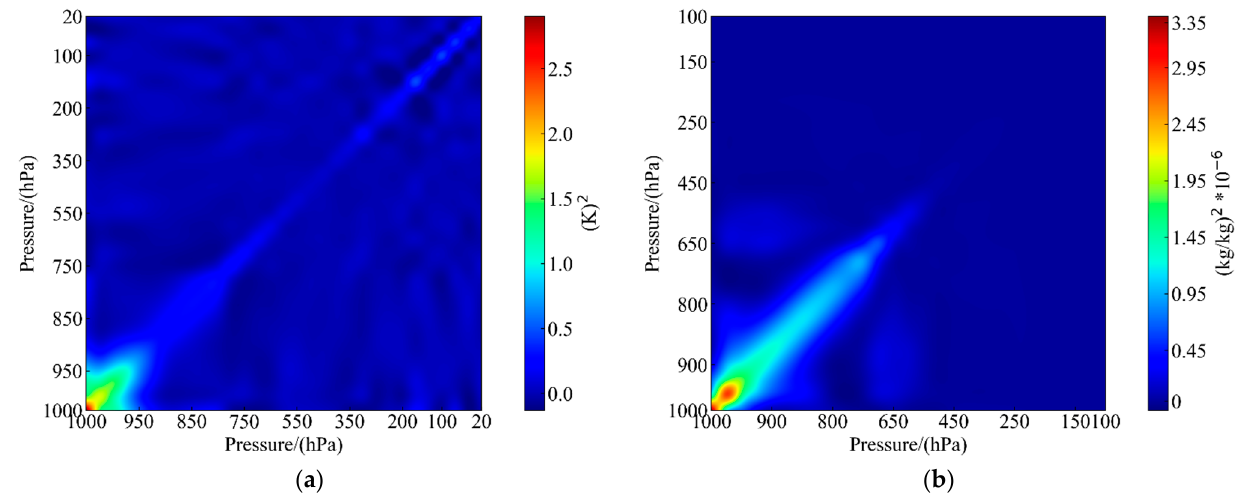
Figure 11. Background error covariance. ( a ) Temperature; ( b )